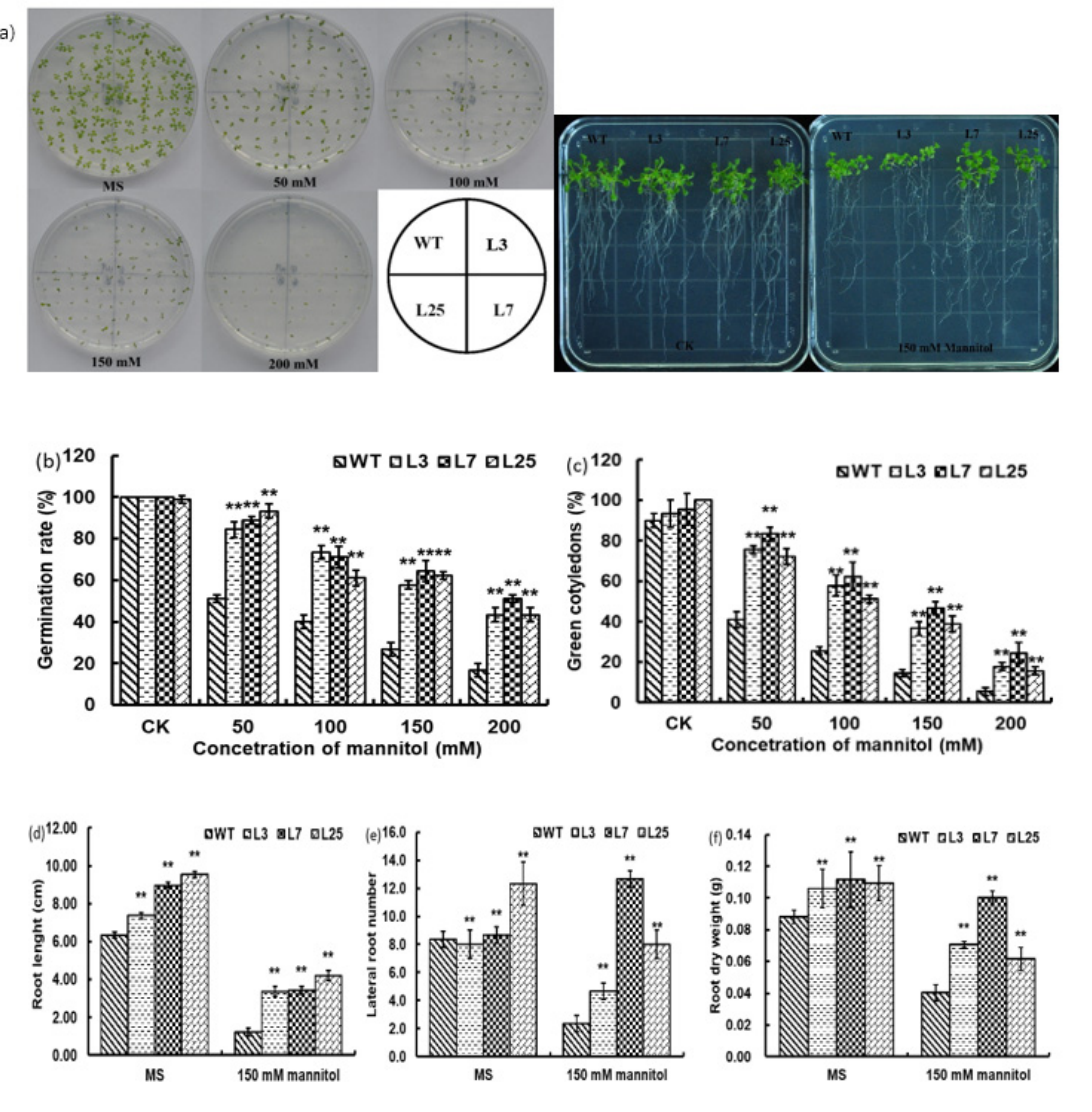
Figure 6. The morphological characteristics of transgenic Arabidopsis thaliana were different under the mannitol treatments (CK, 50, 100, 150 and 200 mM). ** indicate a significant difference at the 1% level. ( a ) The germination and root morphology of plants treated with mannitol were studied. ( b ) Germination rate (%). ( c ) Green cotyledons (%). ( d ) The root length was measured on the 20th day. ( e ) The number of lateral roots was measured on the 20th day. ( f ) Root dry weight was measured on the 20th day ( g ).